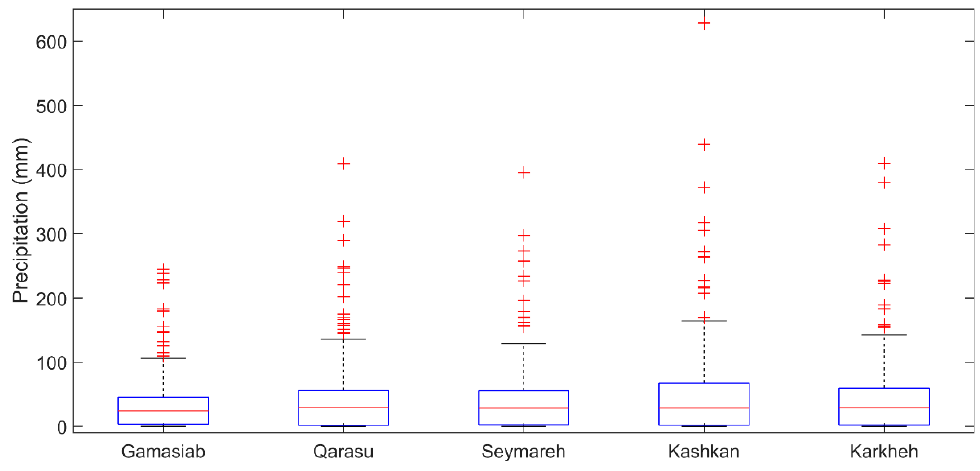
Figure 9. Monthly P data variability for the KRB sub-catchments using GPM-IMERG-Late data. For each box, the central red line indicates median, and the bottom and top of the box indicate 1st and 3rd quartiles (q1 and q3), respectively. Whiskers denote the most extreme values not considered outliers ‘+’ as data points whose distance to q3 was more than 2.7 × SD × (q3–q1 ).